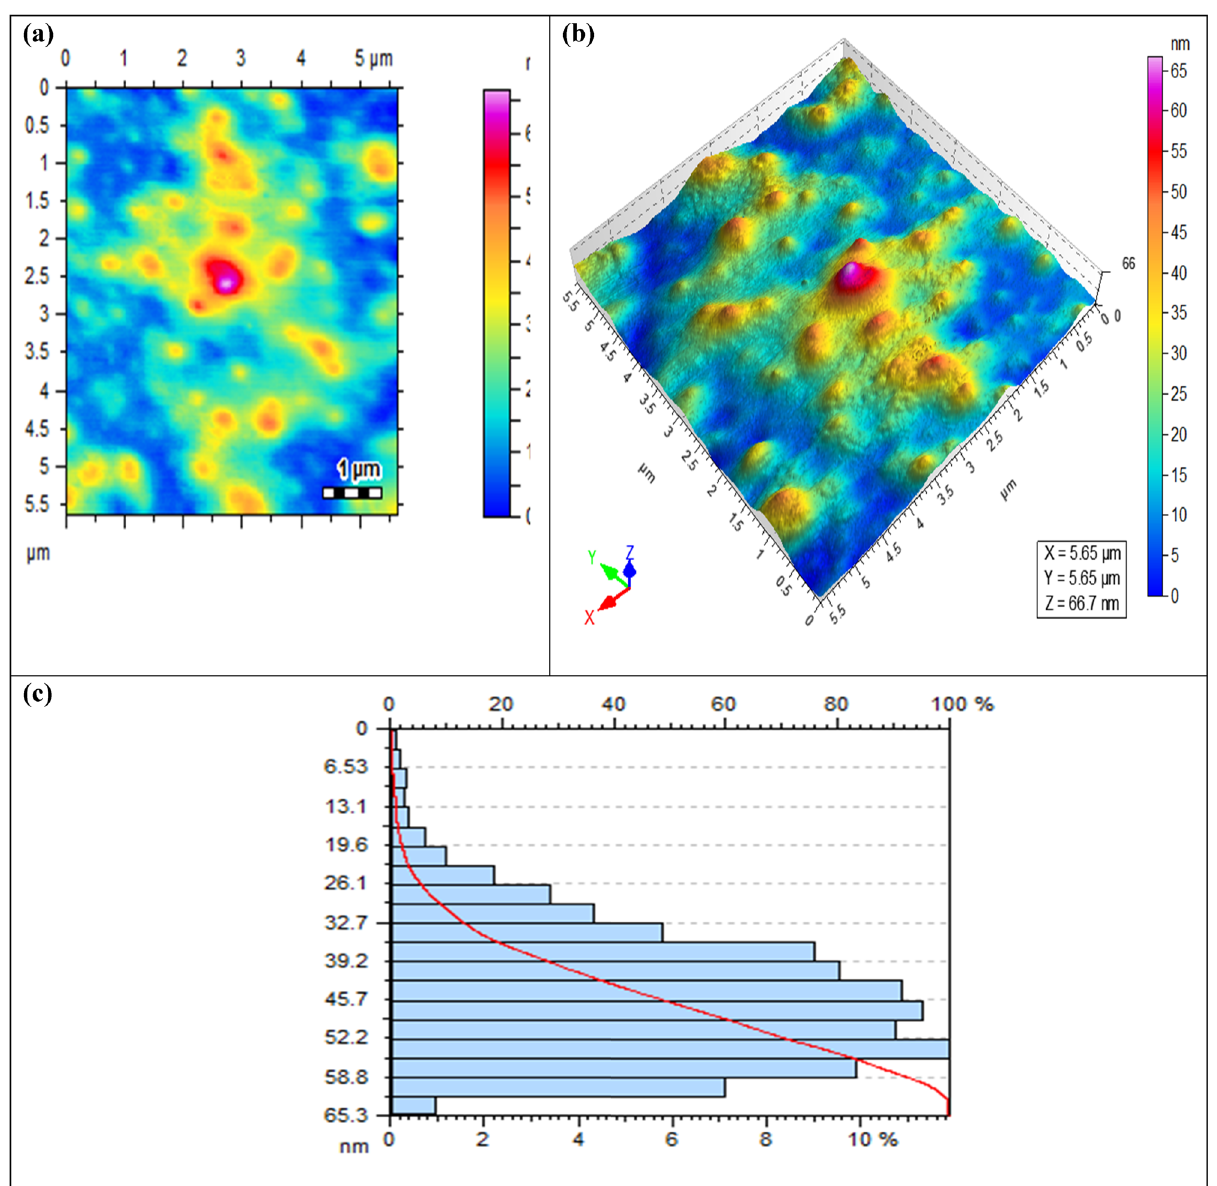
Figure 9: ( a ) Tapping mode AFM images of SNP synthesized with crude methanol fraction of T. govanianum . The scale bar of 100 nm is labeled in the image. ( b ) 3 µm × 3 µm AFM image showing a 2D view of silver NPs of T. govanianum . ( c ) Particle size distribution. The size distribution of synthesized SNP is